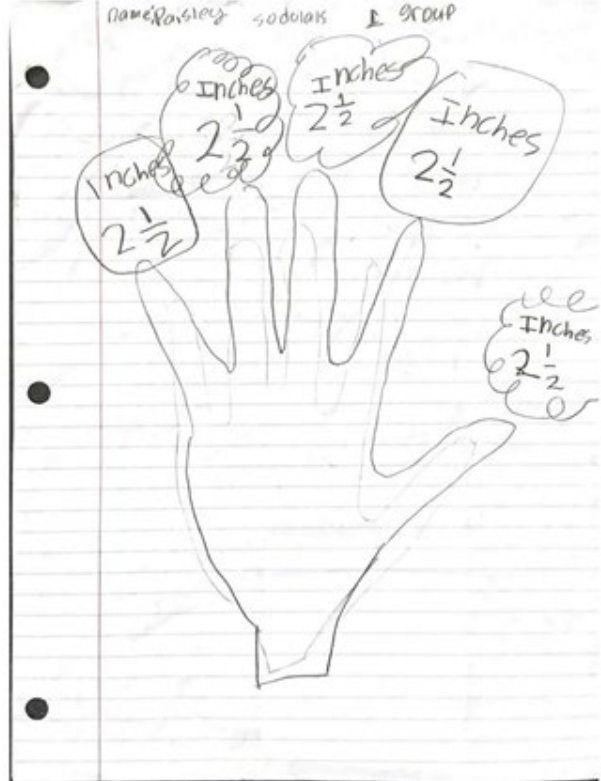
Figure 2. Paula’s work for Lesson